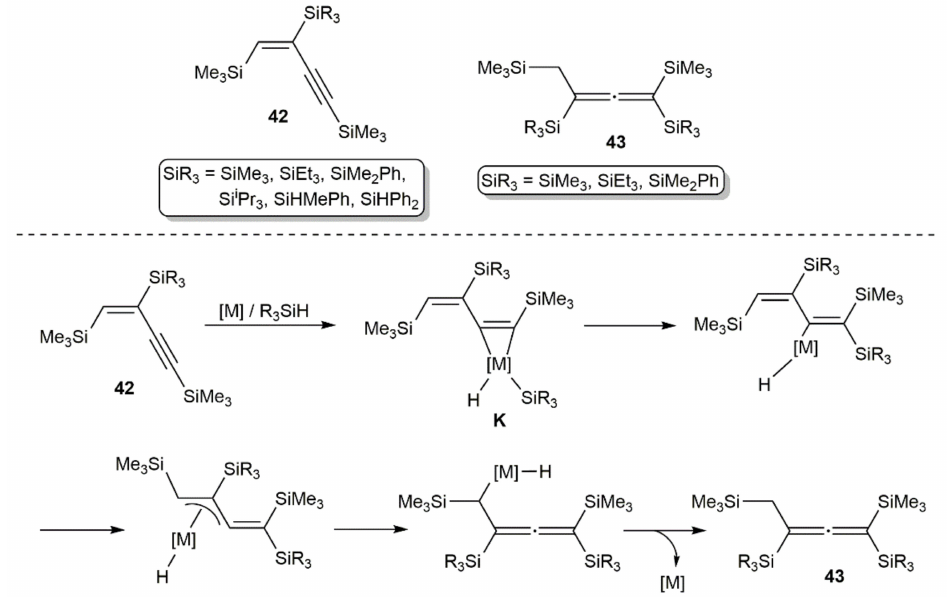
Figure 6. Structure of compounds 42 and 43 , and how 43 are formed from 42